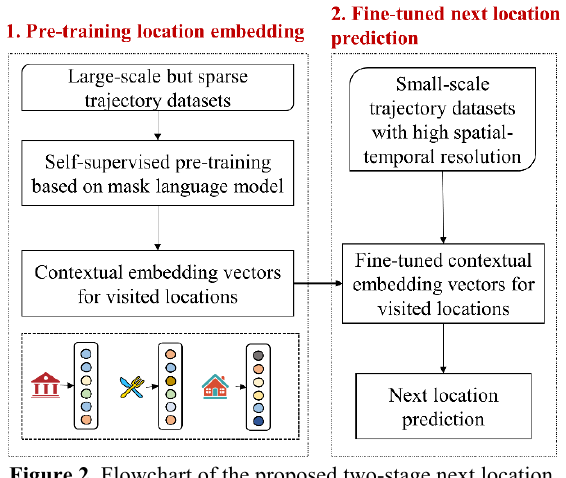
Figure 2 . Flowchart of the proposed two-stage next location prediction